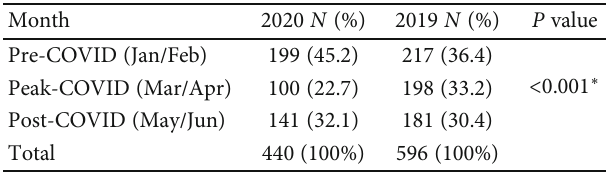
Table 1: Comparison of the ischemic stroke volume in 2020 and 2019 time